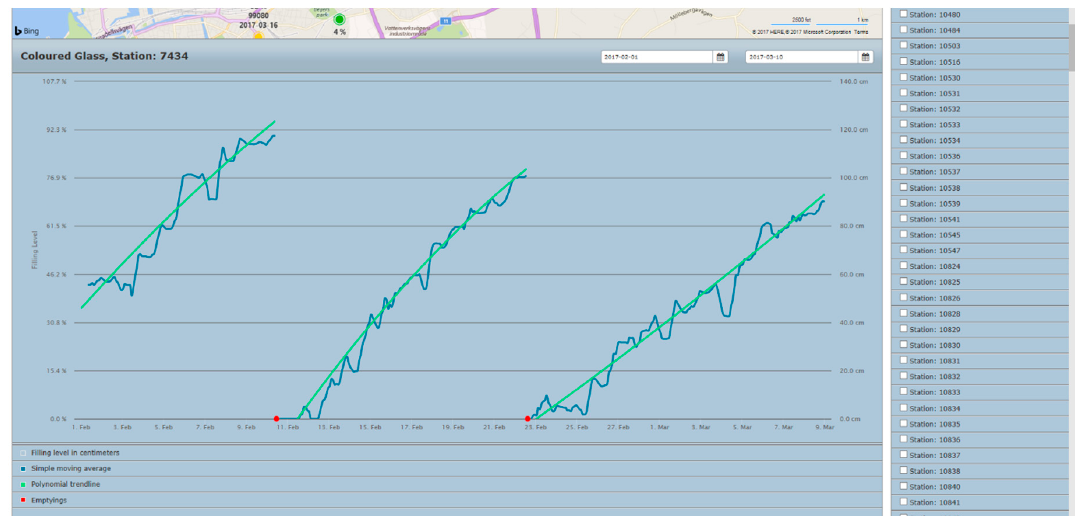
Figure 5. Decision-making graphs—drill-down on container filling levels.